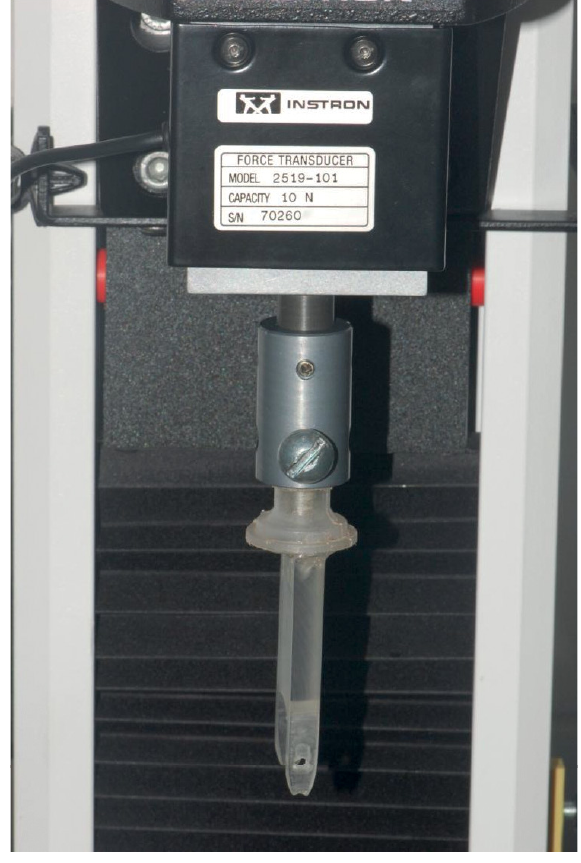
Figure 3. Instron Universal Testing Machine used in this study, with 10 N load cell and the activation